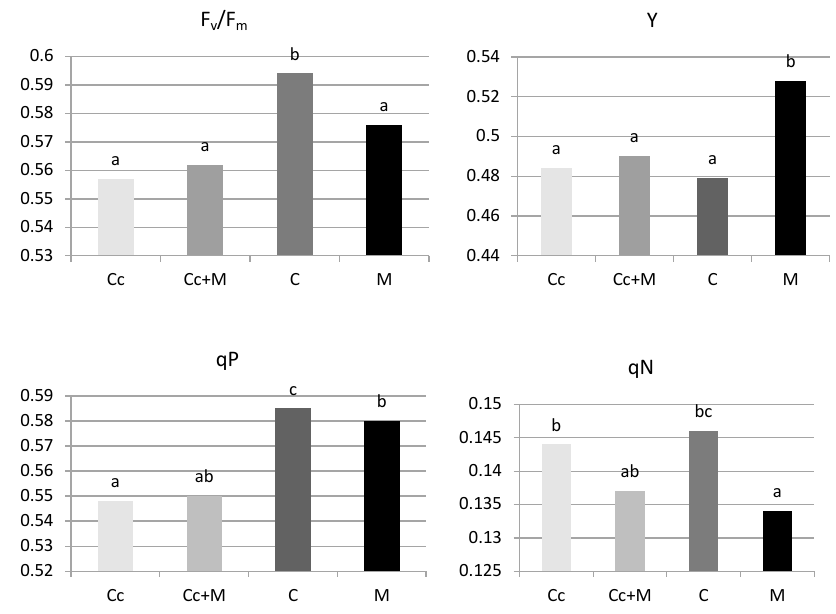
Fig. 1 Photosynthetic activity of tomato seedlings in the experimental combinations. Values marked with the same letters for chlorophyll fluorescence parameters do not differ significantly at p ≤ 0.05 (Tukey’s test); For description of abbreviations, see Tab. 1.